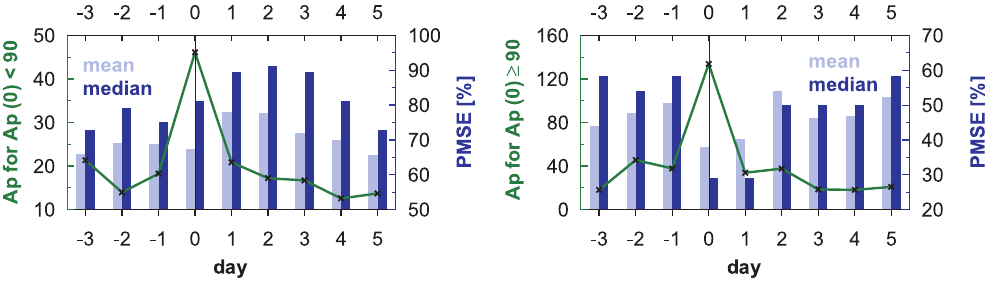
Fig. 2. Superimposed epoch analyses of the PMSE occurrence rates (blue bars) and the corresponding A p indices (green curve) using for key day 0: 35 ≤ A p max < 90 basing on 20 intervals (left panel) and for A p max ≥ 90 basing on 9 intervals (right panel) during